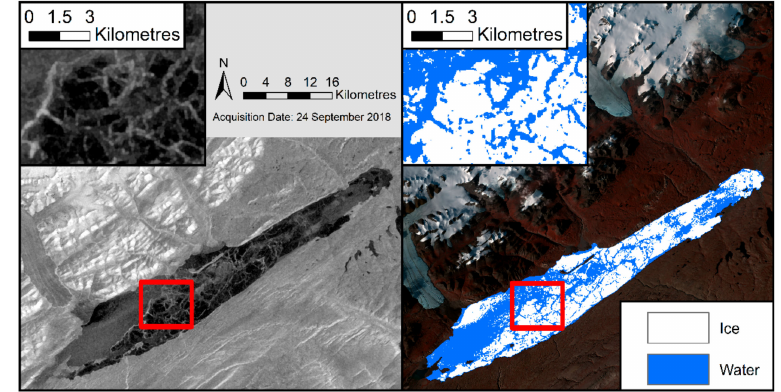
Figure 14. Misclassification of cracks and deformations in the ice surface by the Otsu method during freeze-up in 2018. Landsat-8 Level-1 image courtesy of the U.S. Geological Survey (Digital Object Identifier (DOI) number: / 10.5066 / F71835S6); this figure also contains Copernicus Sentinel-1 data (2018), processed by